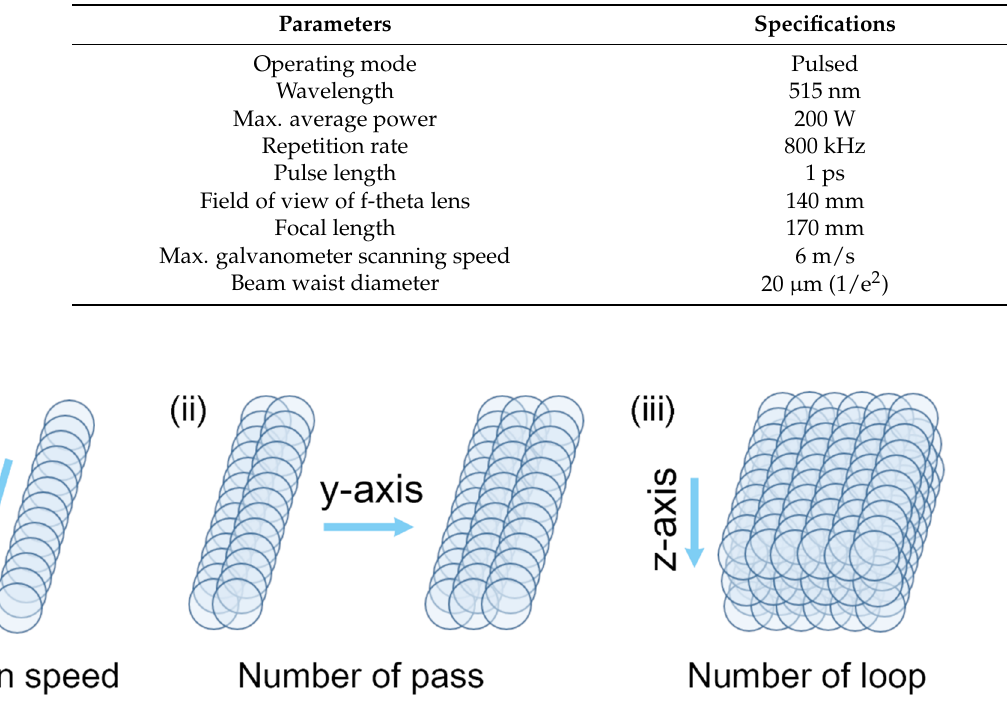
Table 1. Specifications of green picosecond laser system.